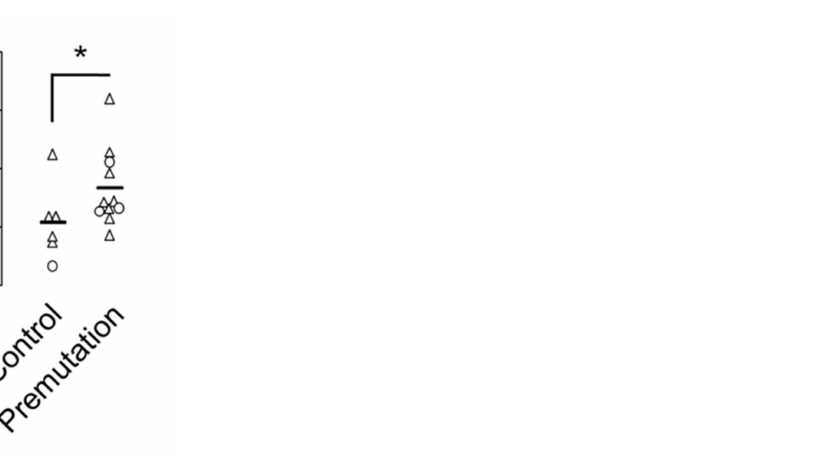
Figure A1. Significant increase of protein carbonylation in the plasma of premutation carriers. Triangles ( ∆ ), female samples; circles (O), male samples. The mean is indicated as a horizontal bar. *, p < 0.05, Mann-Whitney U-test.